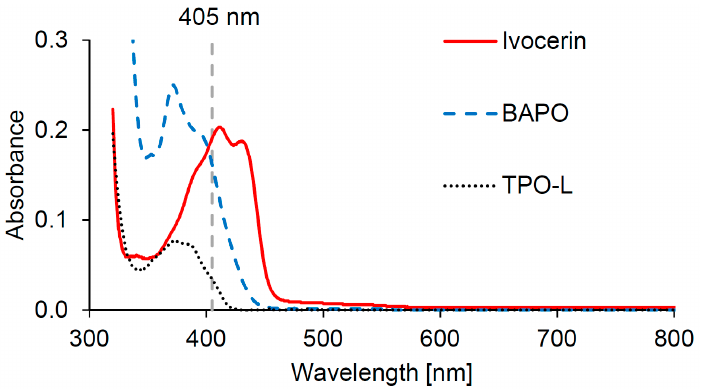
Figure 1. Absorbance spectra of 0.01 wt % photoinitiators in IBOMA.